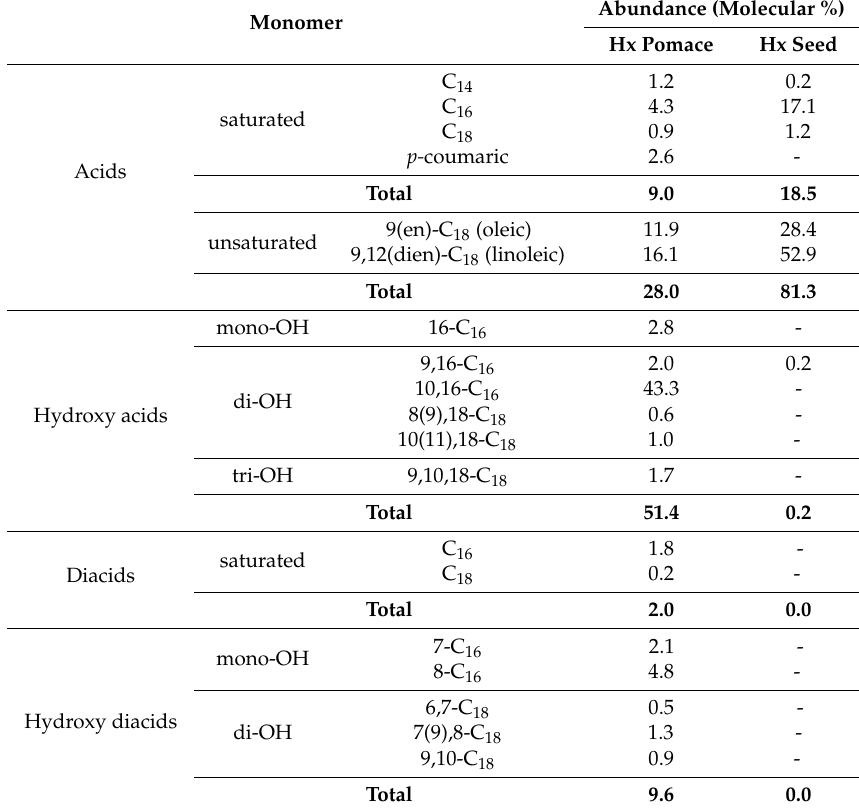
Table 2. Monomeric composition of Hx fractions extracted from tomato pomace and isolated seeds by alkaline